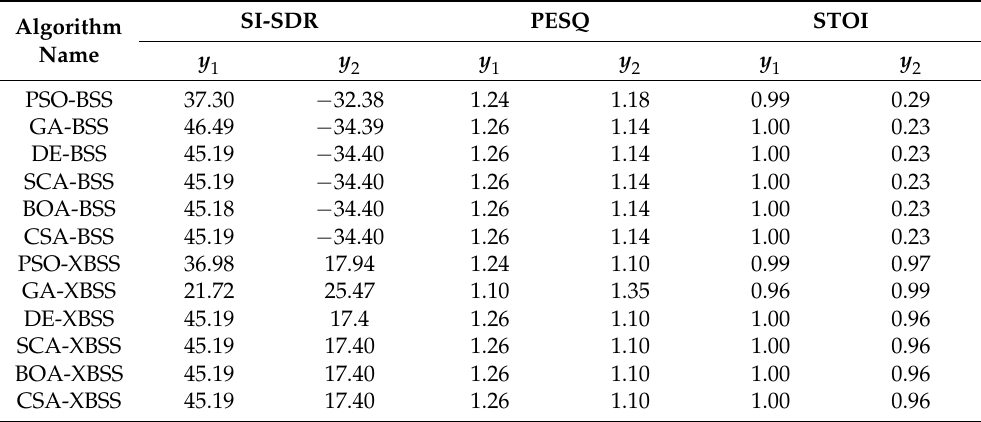
Table 3. Comparison of the evaluation mean values of SI-SDR, PESQ, and STOI. ( y 1 represents the first separated signal, y 2 represents the other separated signal).